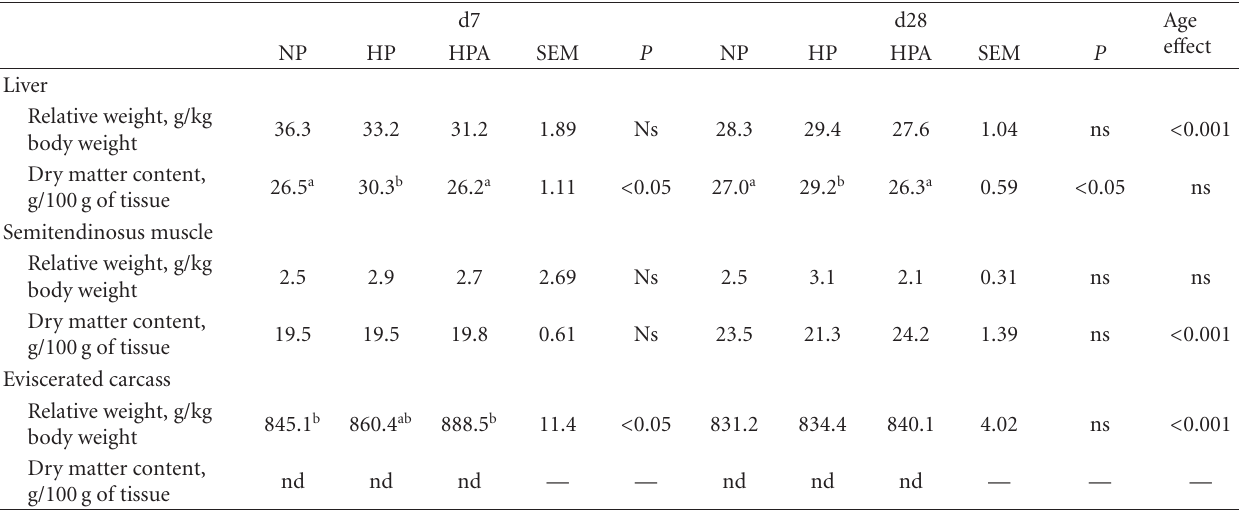
Values are least square means and pooled SEM calculated in pigs slaughtered at d7 and d28, n = 6/group. P (e ff ect of formula) and age e ff ects are presented. Di ff erences were considered significant when P < 0 . 05 but trends are presented when 0.1 < P < 0 . 05. Means with a di ff erent superscript letter di ff er at P < 0 . 05. nd: not